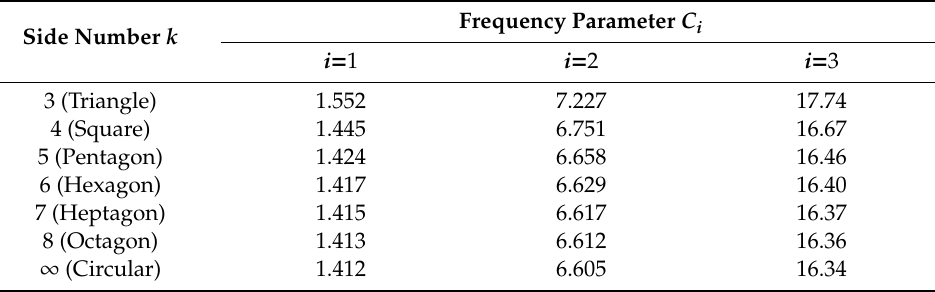
Table 4. E ff ect of side number k on frequency parameter C i .